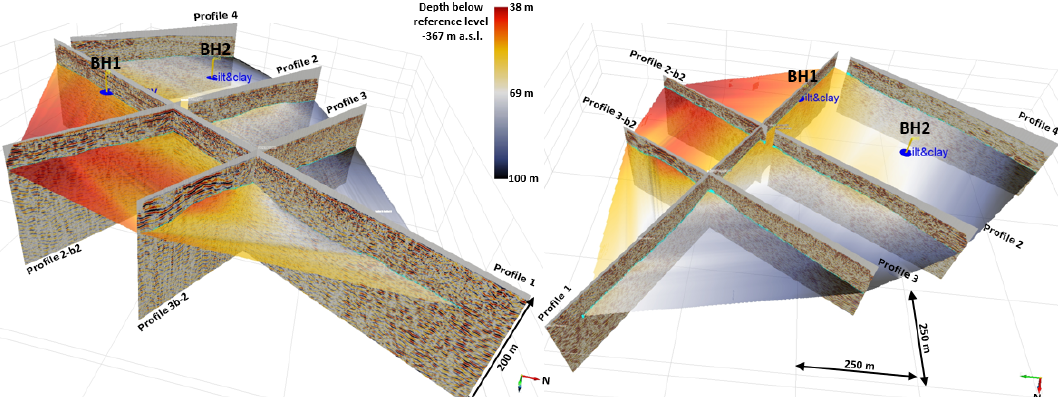
Figure 12. Three-dimensional representation of the 2.5-D profiling grid (cf. sections in Figs. 8–11), restricted to 200m depth (no vertical exaggeration). Boreholes BH1 and BH2 are included as yellow bars representing the sand and gravel sequence above the detected silt and clay layer, the top of which is marked by a blue disc along each well shaft. Light blue lines along the profiles mark the interpreted continuation of the top of this layer starting from BH1 along profile 1 and subsequently continuing to the crossing profiles. The constructed horizon by triangular interpolation represents the derived top of the silt and clay layer below the reference datum of − 367ma.s.l. based on the drilling and seismic results. At the deepest parts towards the Dead Sea border the top of this layer reaches nearly − 467ma.s.l., which is 60m below the level of the current alluvium–mudflat transition of − 407ma.s.l. calculated by Al-Halbouni et al.